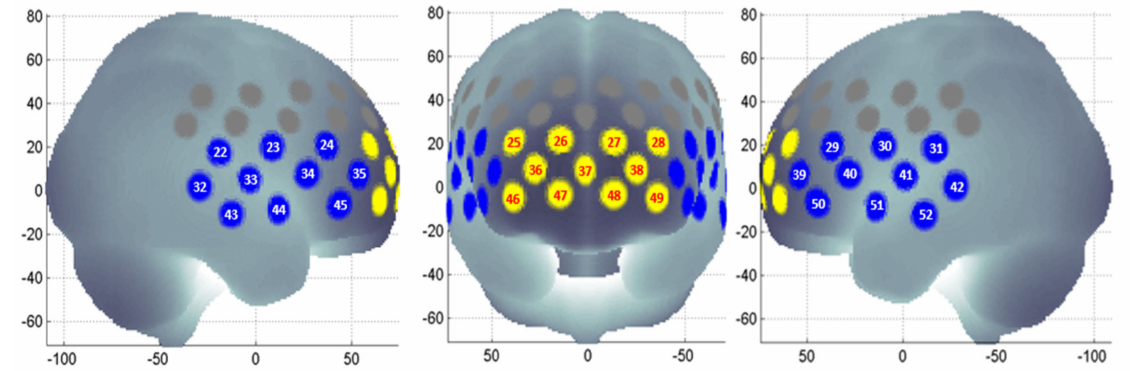
Figure 2. Regions of interest. Probe locations in the frontal (yellow) and temporal regions (blue) used for near-infrared spectroscopy (NIRS). Channel positions were plotted using the NFRI functions toolbox